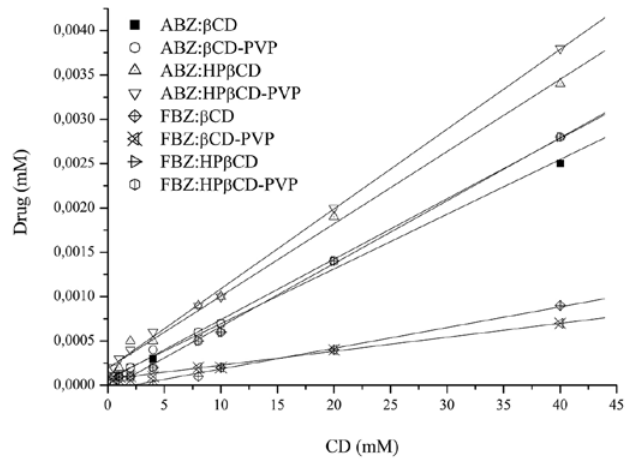
FIGURE 1 - Phase solubility diagram of the drugs (ABZ and FBZ) in the presence of the CDs.